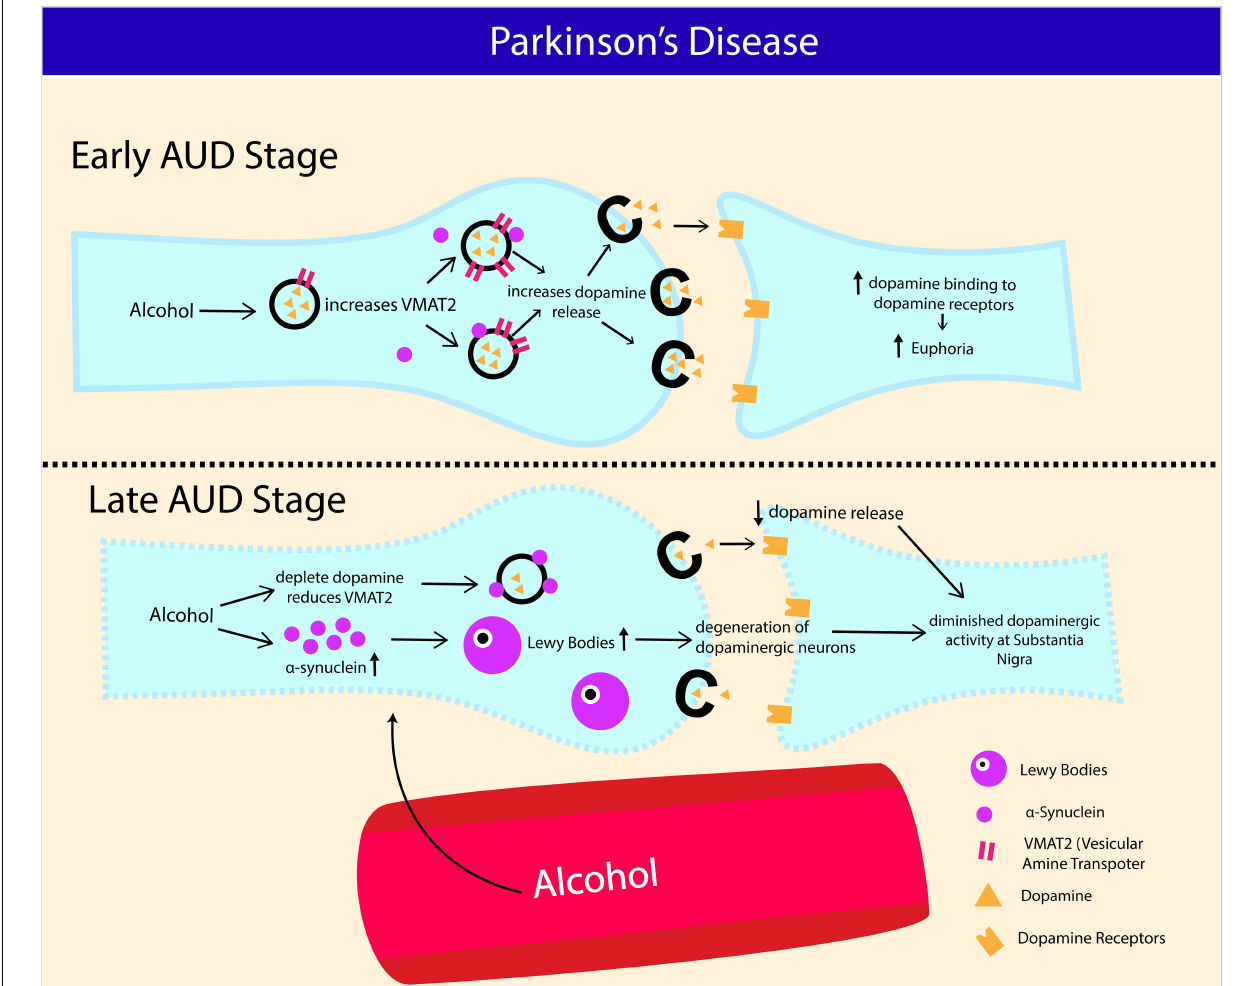
FIGURE 4 | Potential association between Alcohol Use Disorder and development of Parkinson’s disease (PD). Increase in α -synuclein production and nigrostriatal dopaminergic neurodegeneration contribute to Parkinson’s disease (PD) progression. At early stage of AUD, alcohol consumption transiently increases vesicular monoamine transporter (VMAT2) activity and dopamine release in nigrostriatal reward pathway. Chronic binge alcohol intake exhausts dopamine content and consequently reducing VMAT2 activity in striatal neurons (caudate putamen and nucleus). Increased expression of α -synuclein in AUD also restricts the release of dopaminergic synaptic vesicles via reduced (VMAT2) activity. Chronic alcohol intake causes α -synuclein aggregation, leading to formation of Lewy bodies, which eventually results in degeneration of dopaminergic neurons at substantia